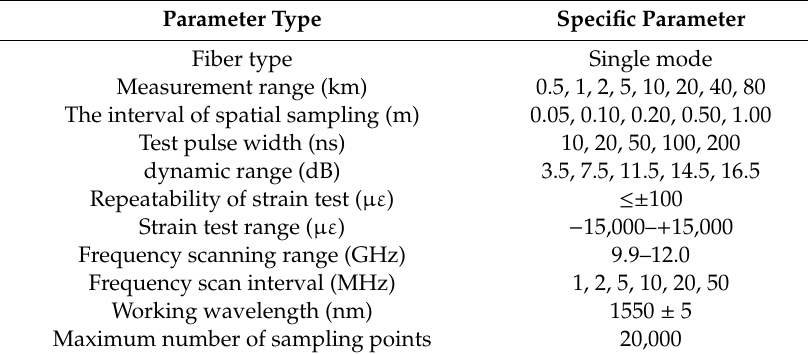
Table 2. Specifications of the AV6419 analyzer.